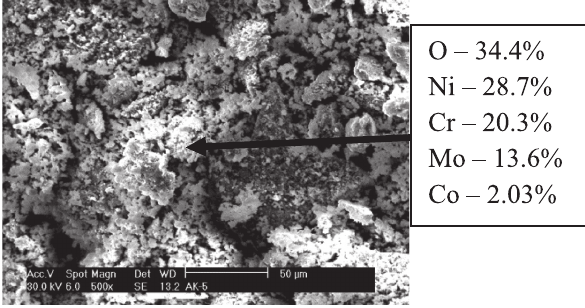
Fig. 7: EDAX results indicating presence of Mo and Co along with Ni and Cr oxides exposed at 1000 °C in mixed salt